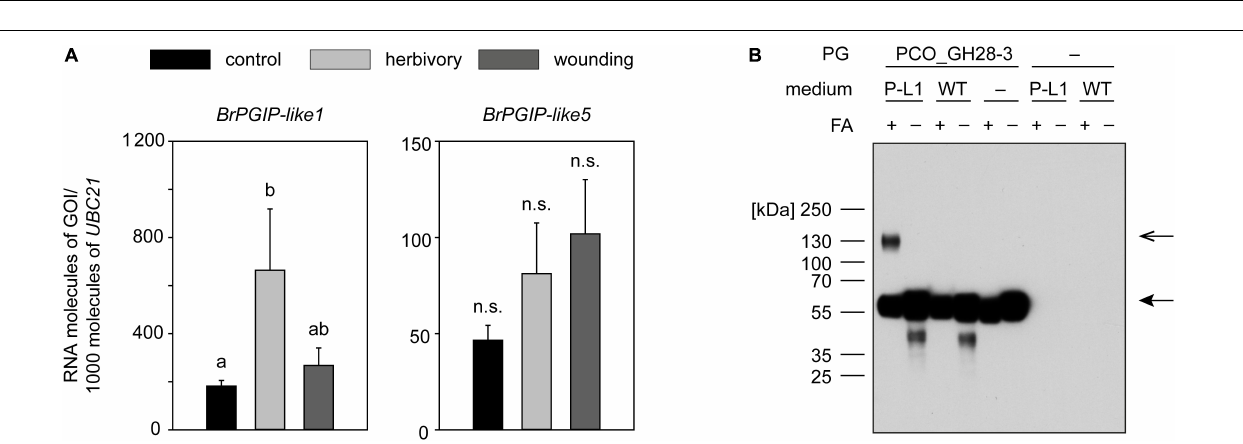
FIGURE 3 | Regulation of BrPGIPs in response to P. cochleariae feeding and mechanical wounding. The expression levels of the BrPGIPs were quantified by RT-qPCR in untreated control plants (black), after P. cochleariae feeding (light gray) and mechanical wounding (dark gray). Transcript abundance is expressed as RNA molecules of the gene of interest (GOI) per 1000 RNA molecules of reference gene UBIQUITIN-CONJUGATING ENZYME 21 ( UBC21 ). Gene expression levels were compared between the three treatments ( n = 5). Letters indicate significant differences ( p < 0.05) between the groups based on an ANOVA on ranks or ANOVA followed by a Student–Newman–Keuls post hoc test. Error bars indicate the standard error of the mean (SEM). n.s., not significant.